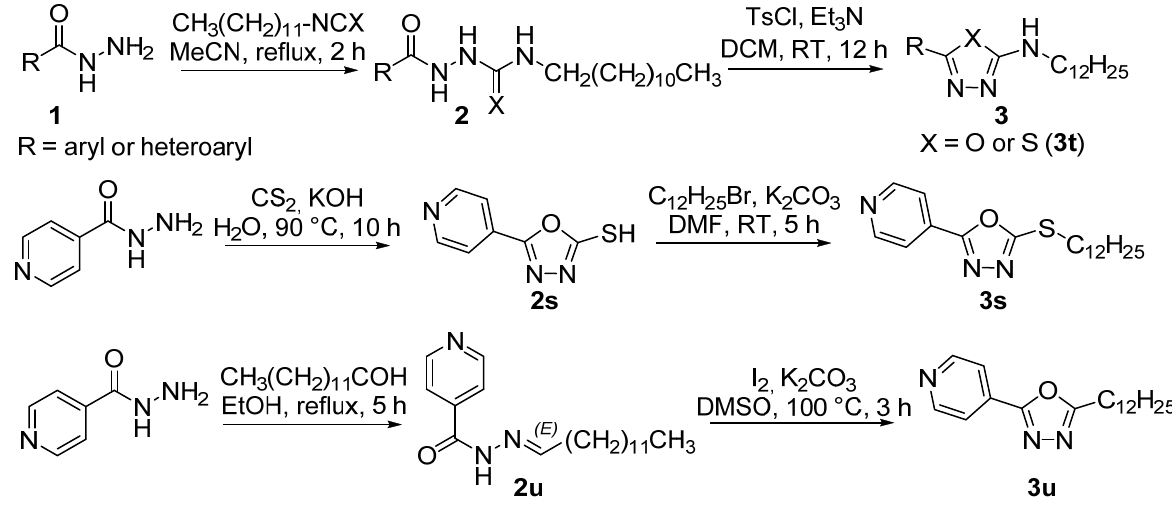
Figure 2. Synthesis of the targeted derivatives 3 (DCM: dichloromethane, DMF: N , N -dimethylformamide, DMSO: dimethylsulfoxide, TsCl: p -toluenesulfonyl chloride, RT: room temperature. 2-Aryl- N -dodecylhydrazine-1-carboxamides 2 (or carbothioamide 2t ) were treated